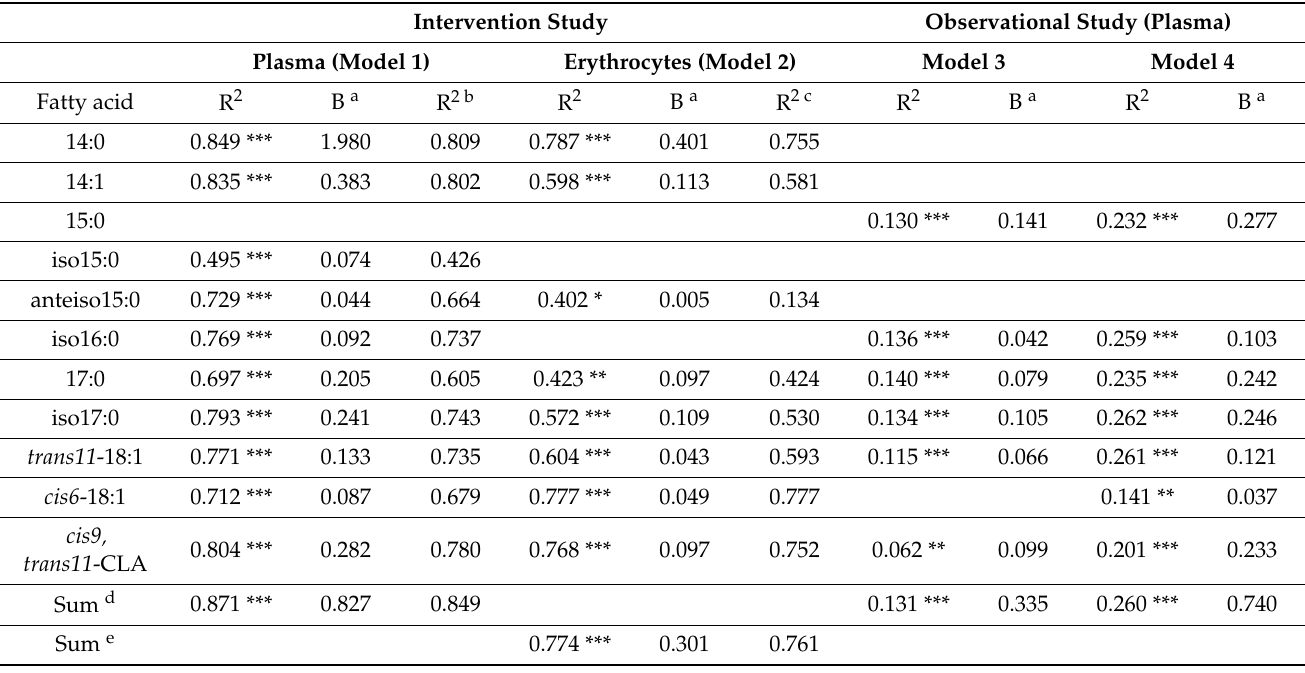
Table 3. Determination (R 2 ) and regression (B) coefficients between the concentration ( µ mol/L) of fatty acids in different types of samples and total dairy fat intake (g/day) from whole milk, full fat yogurt, and fat cheese.